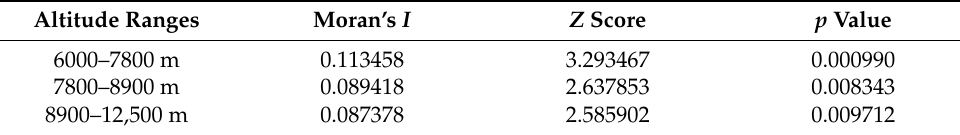
Table 5. Global Moran’s I statistics of FSRA at different altitude ranges.